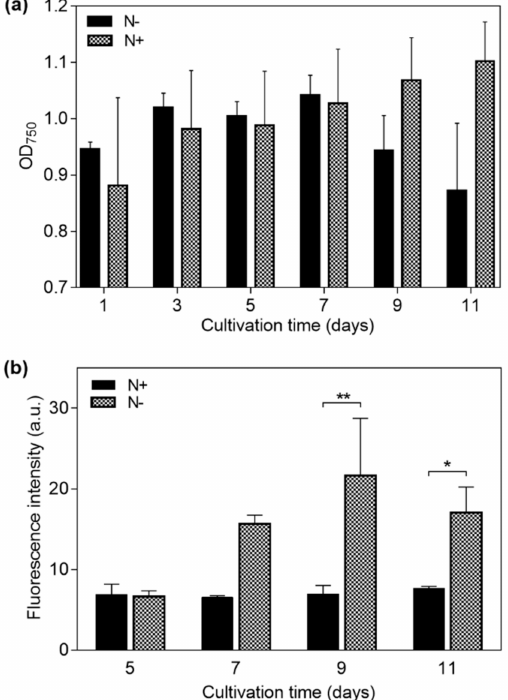
Figure 3. Measurements on Neochloris oleoabundans samples cultured under nitrogen-replete (N+) and nitrogen-deplete (N − ) medium conditions for 11 days. ( a ) Optical density at 750 nm (OD 750 ) for cell density in the suspending medium, and ( b ) fluorescence intensity indicating cell lipid content for days 5, 7, 9, and 11 ( p -values: * ≤ 0.05 and ** ≤